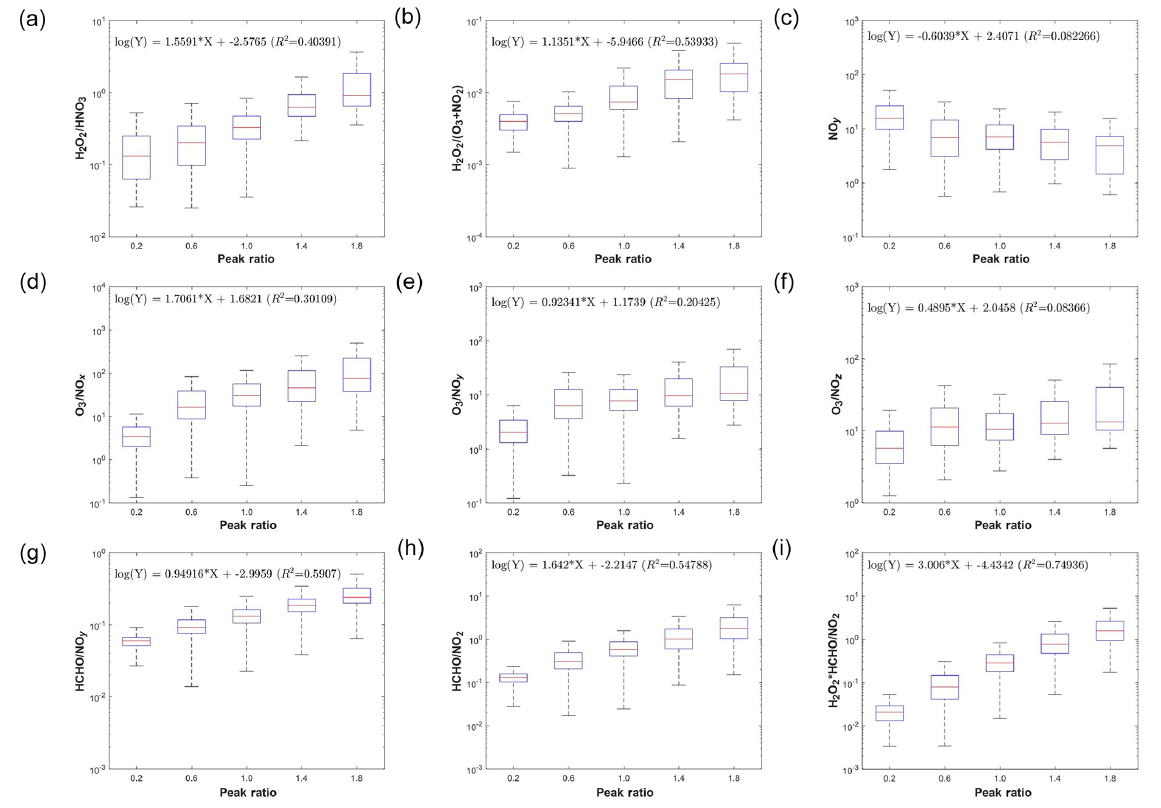
Figure 6. Development of observable responsive indicators for O 3 chemistry based on log-linear regressions between observable indicators and the